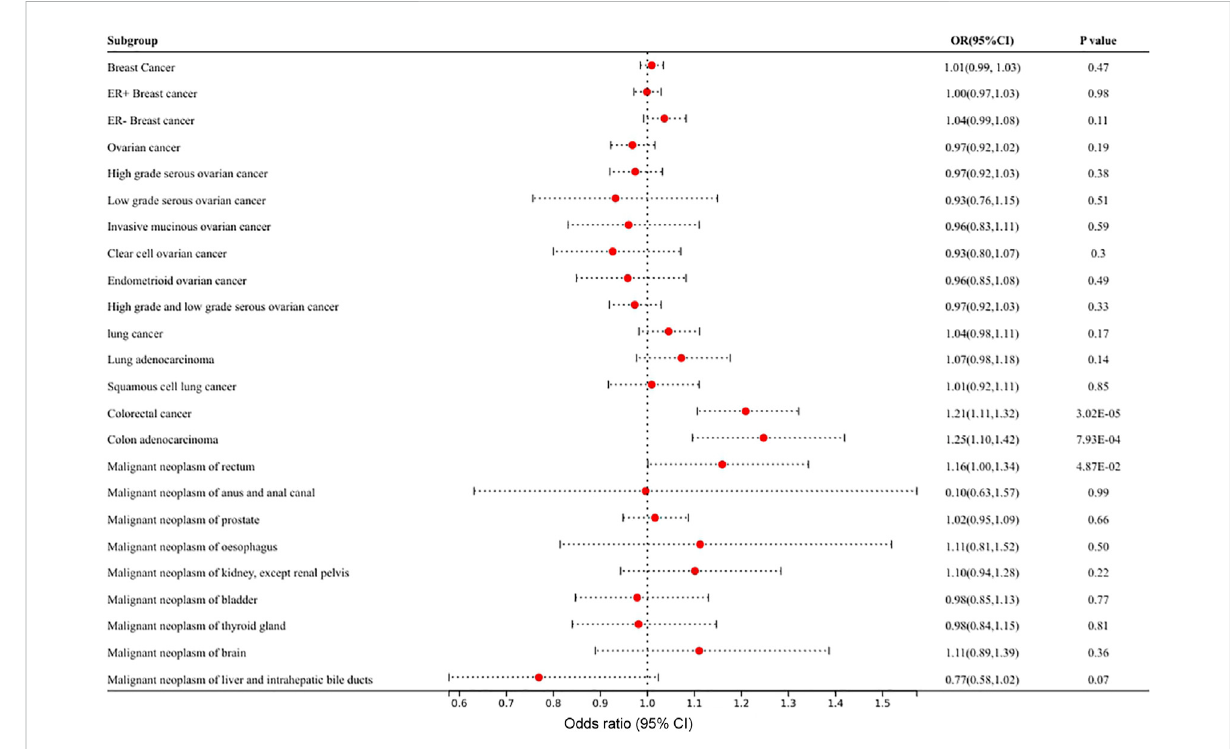
Mendelian randomization results of the association of circulating VEGF on different types of